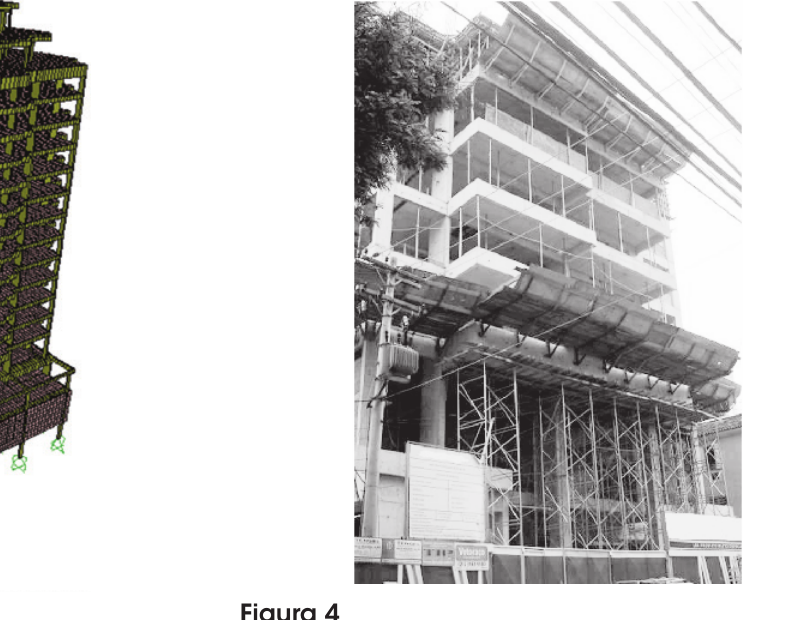
Modelo numérico da edificação em estudo Estágio de construção da 2 a